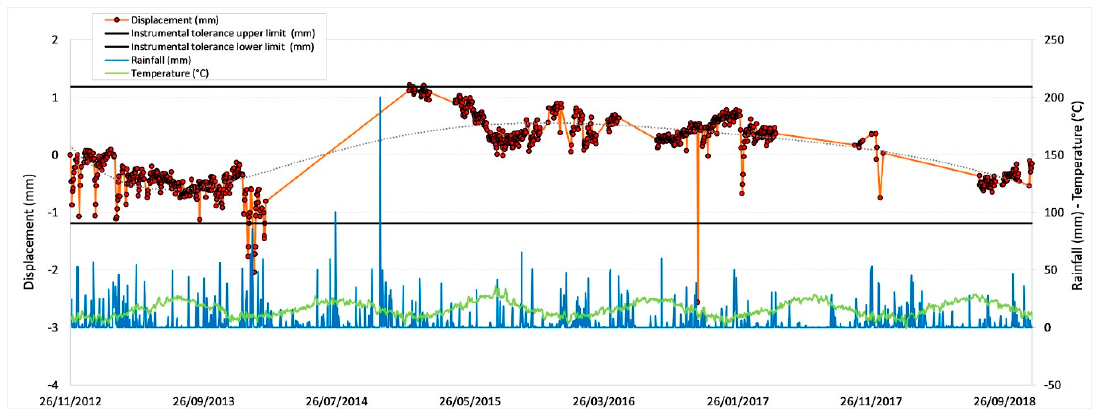
Figure 13. Displacement recorded by the RTS at the measurement point G17. Sensors 2018 , 18 , x FOR PEER REVIEW